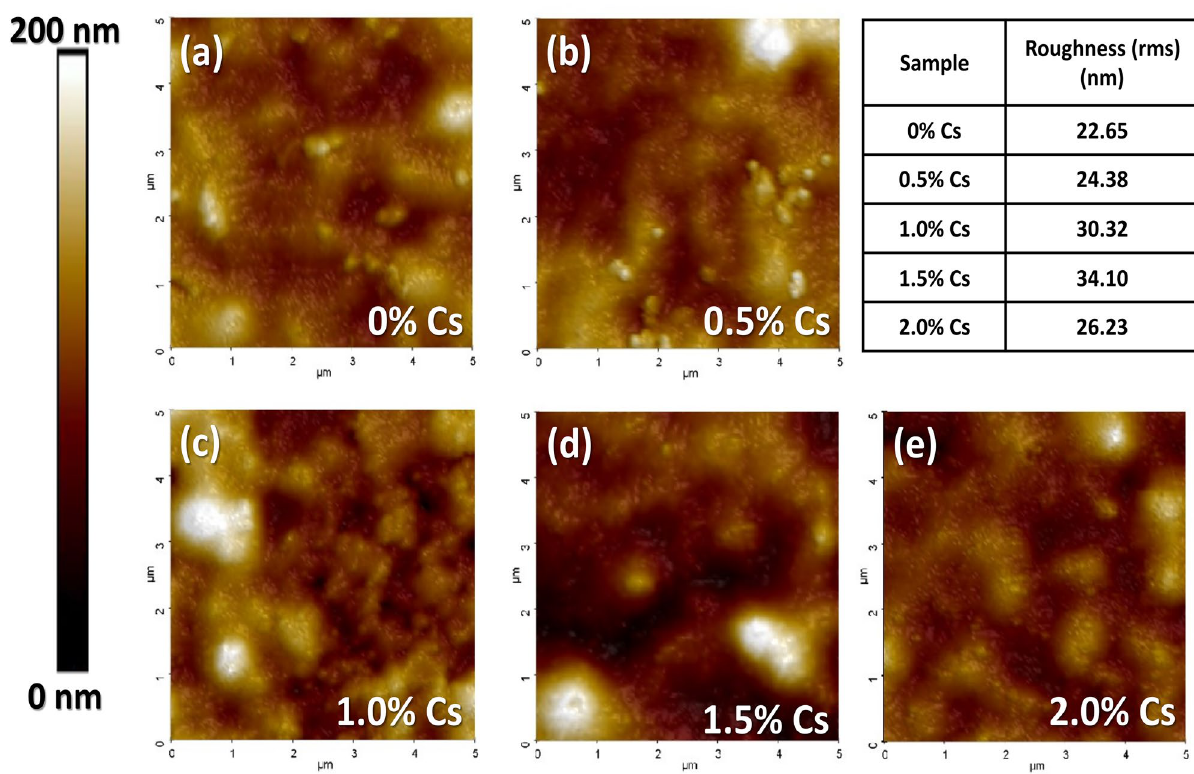
Figure 5. AFM morphology images of 0.8 M (PEA) 2 (Cs x MA 0.61-x FA 0.39 ) 39 (Pb) 40 (Cl 0.88-0.32x Br 0.12+0.32x ) 121 with ( a ) 0% Cs, ( b ) 0.5% Cs, ( c ) 1.0% Cs, (d) 1.5% Cs, and ( e ) 2.0% Cs. The AFM scan size is 5 μm × 5 μm for all